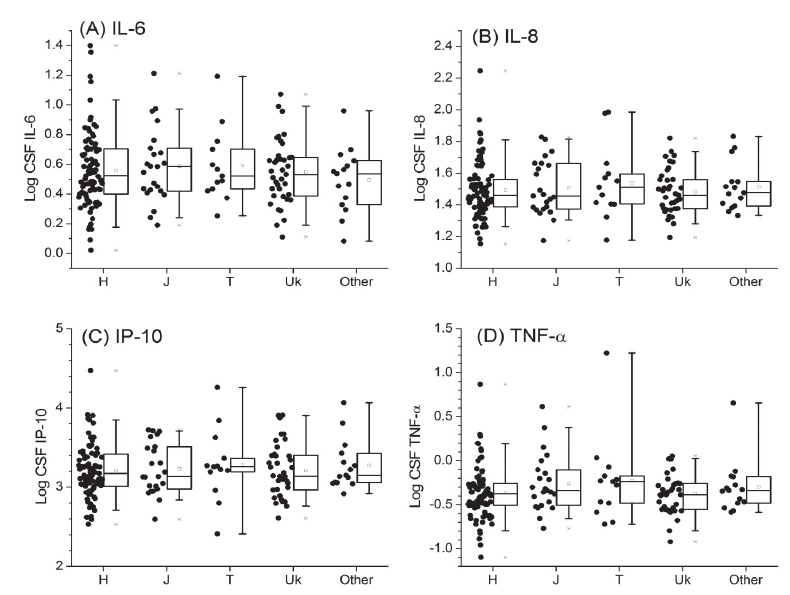
Supplemental Figure 1. Measured cytokine levels in CSF for (A) IL-6, (B) IL-8, (C) IP-10, and (D) TNF-a in participants of European ancestry. Data are shown for each of the major European haplogroups: H, J, T, and Uk. All minor haplogroups are combined into the “other” category.